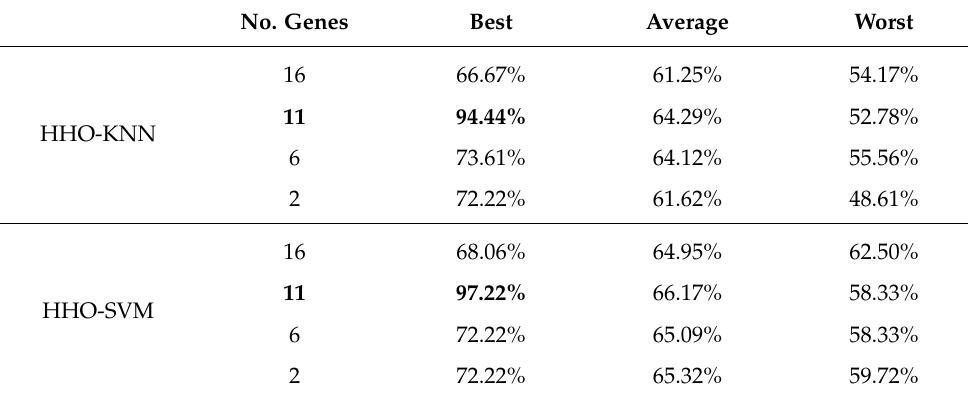
Table 4. Leukemia2 data set